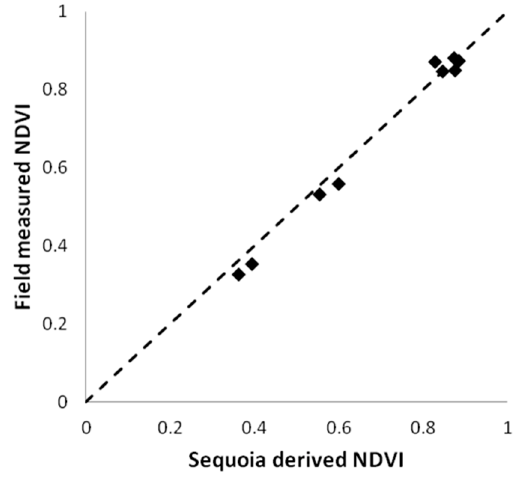
Figure 19. Correlation between NDVI from the Sequoia camera and NDVI from the field spectral data for the nine spectral field plots. R 2 = 0.99.